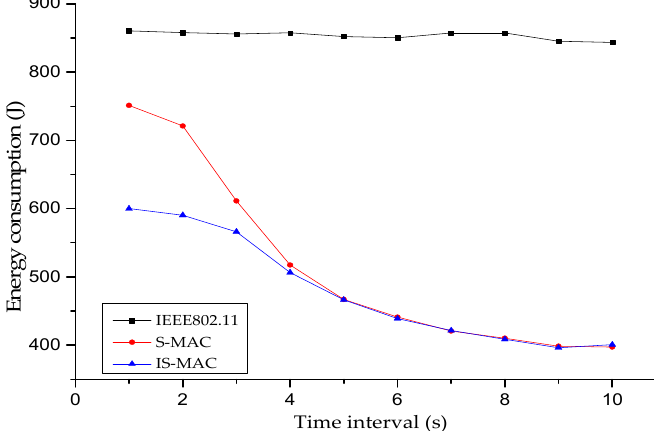
Figure 5. Energy consumption of sensor nodes under different loads.